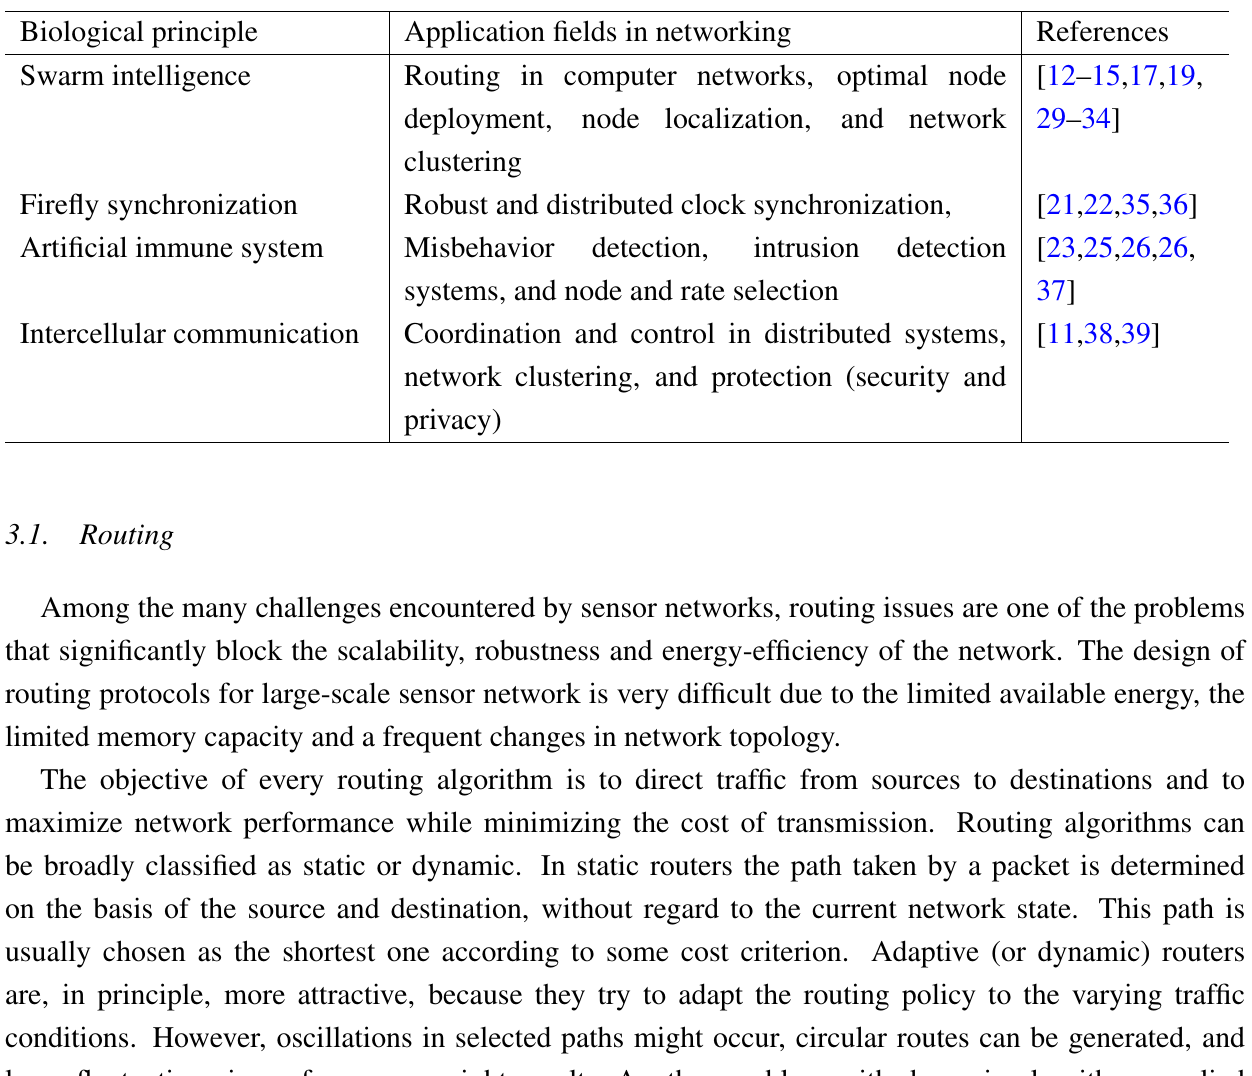
Table 1. Applications of bioinspired principles in